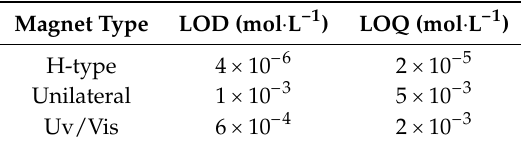
Table 1. Average limits of detection and quantification (LOD and LOQ) of the different spectrometers for the tested paramagnetic ions [22].